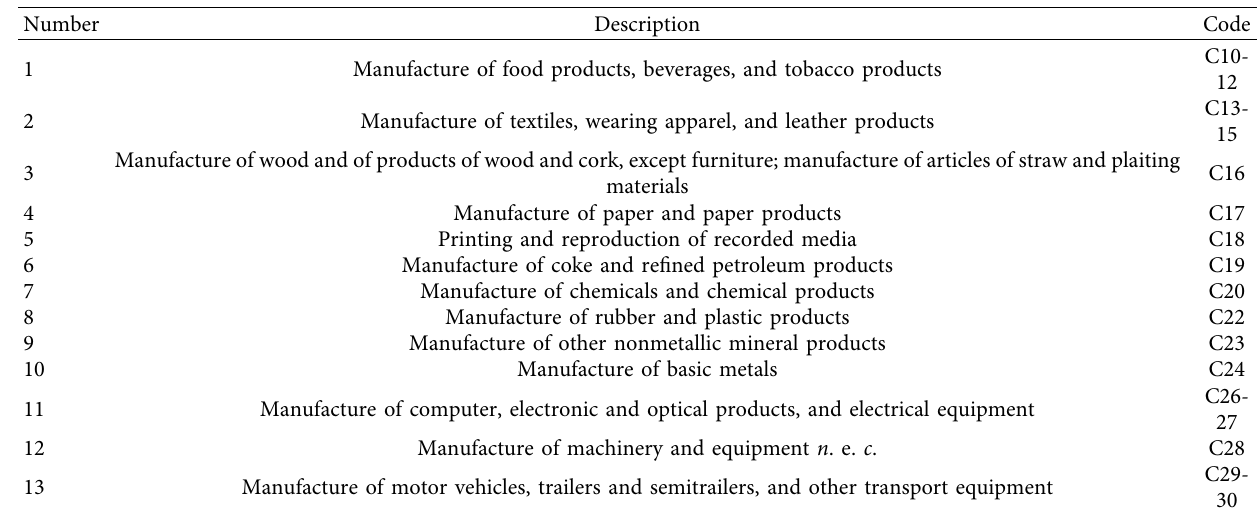
Table 2: Manufacturing